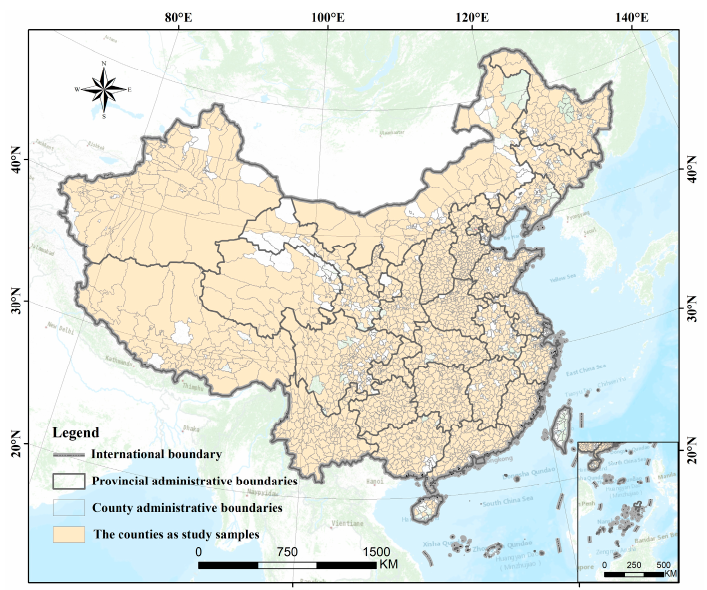
Figure 1. Study area.